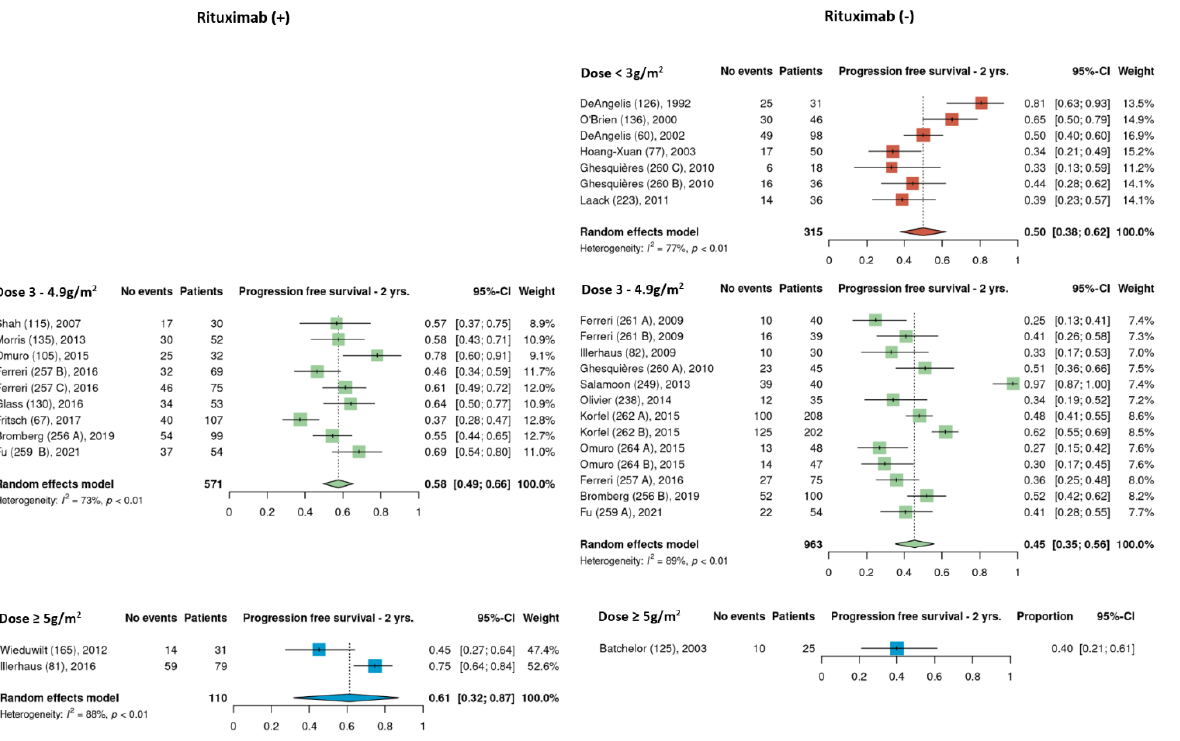
Figure 7. Exploratory comparison of 2-year progression-free survival between cohorts that did and did not receive rituximab among the different HDMTX dose categories [12,14,15,18,21,23,24,26– 39,41,42].